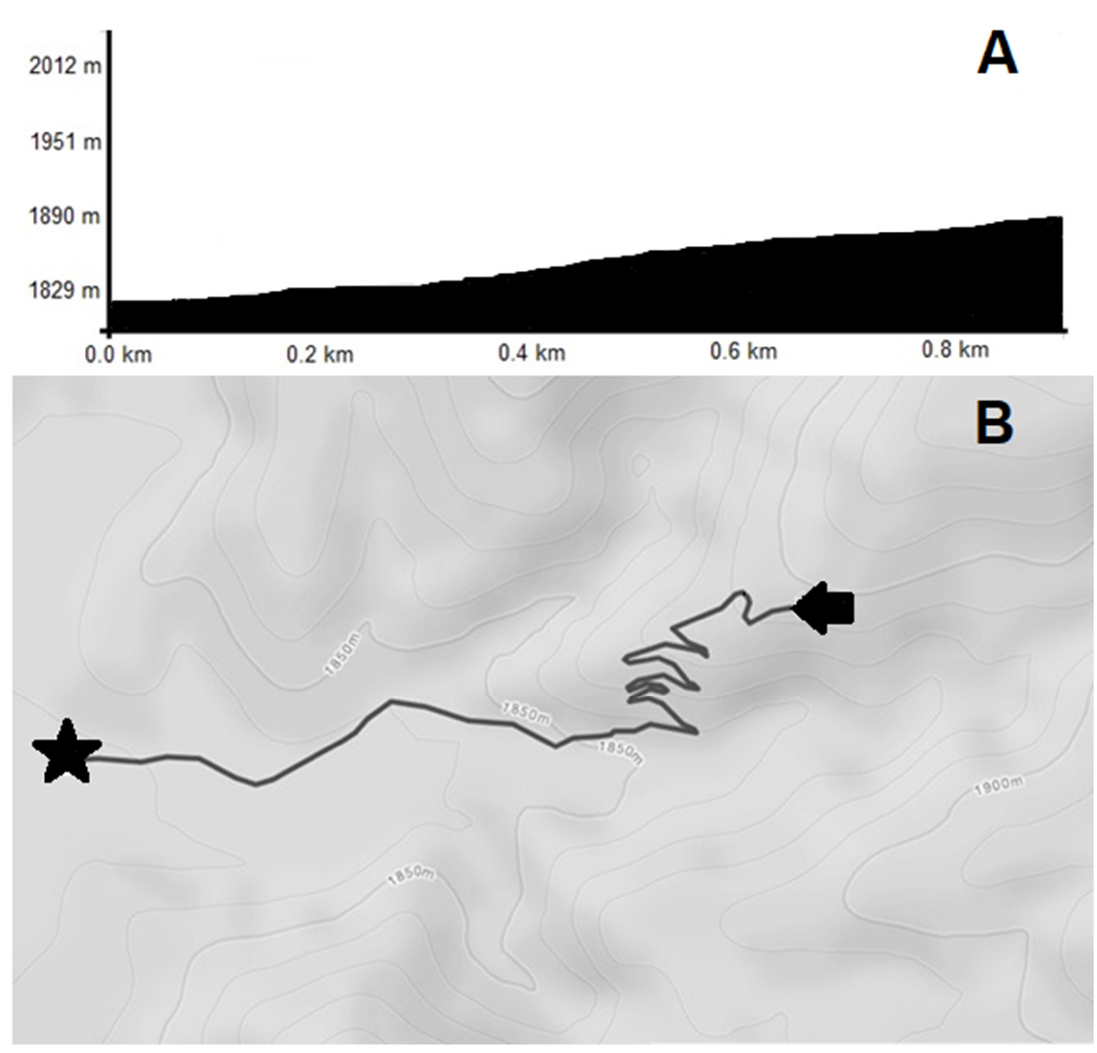
Figure 1. ( A ) Elevation gain experienced by participants over the 0.8 km (0.5 mi) hike. ( B ) Terrain profile of the Lightning Switch Trail section completed by participants.